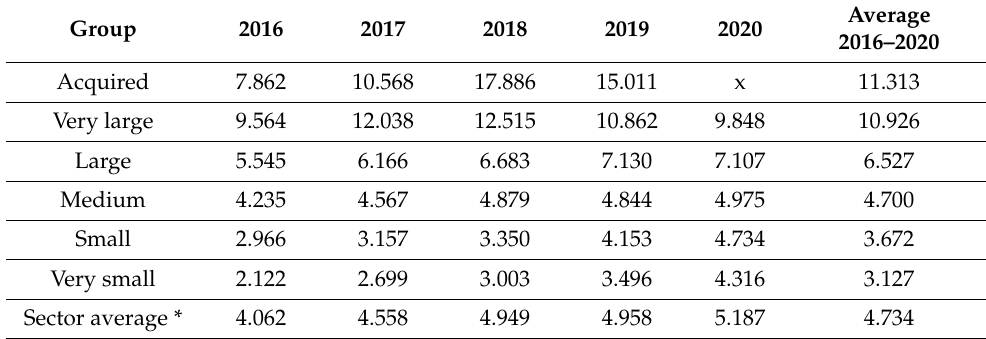
Table 1. NPL level in subgroups of cooperative banks in Poland in 2016–2020 (in%).